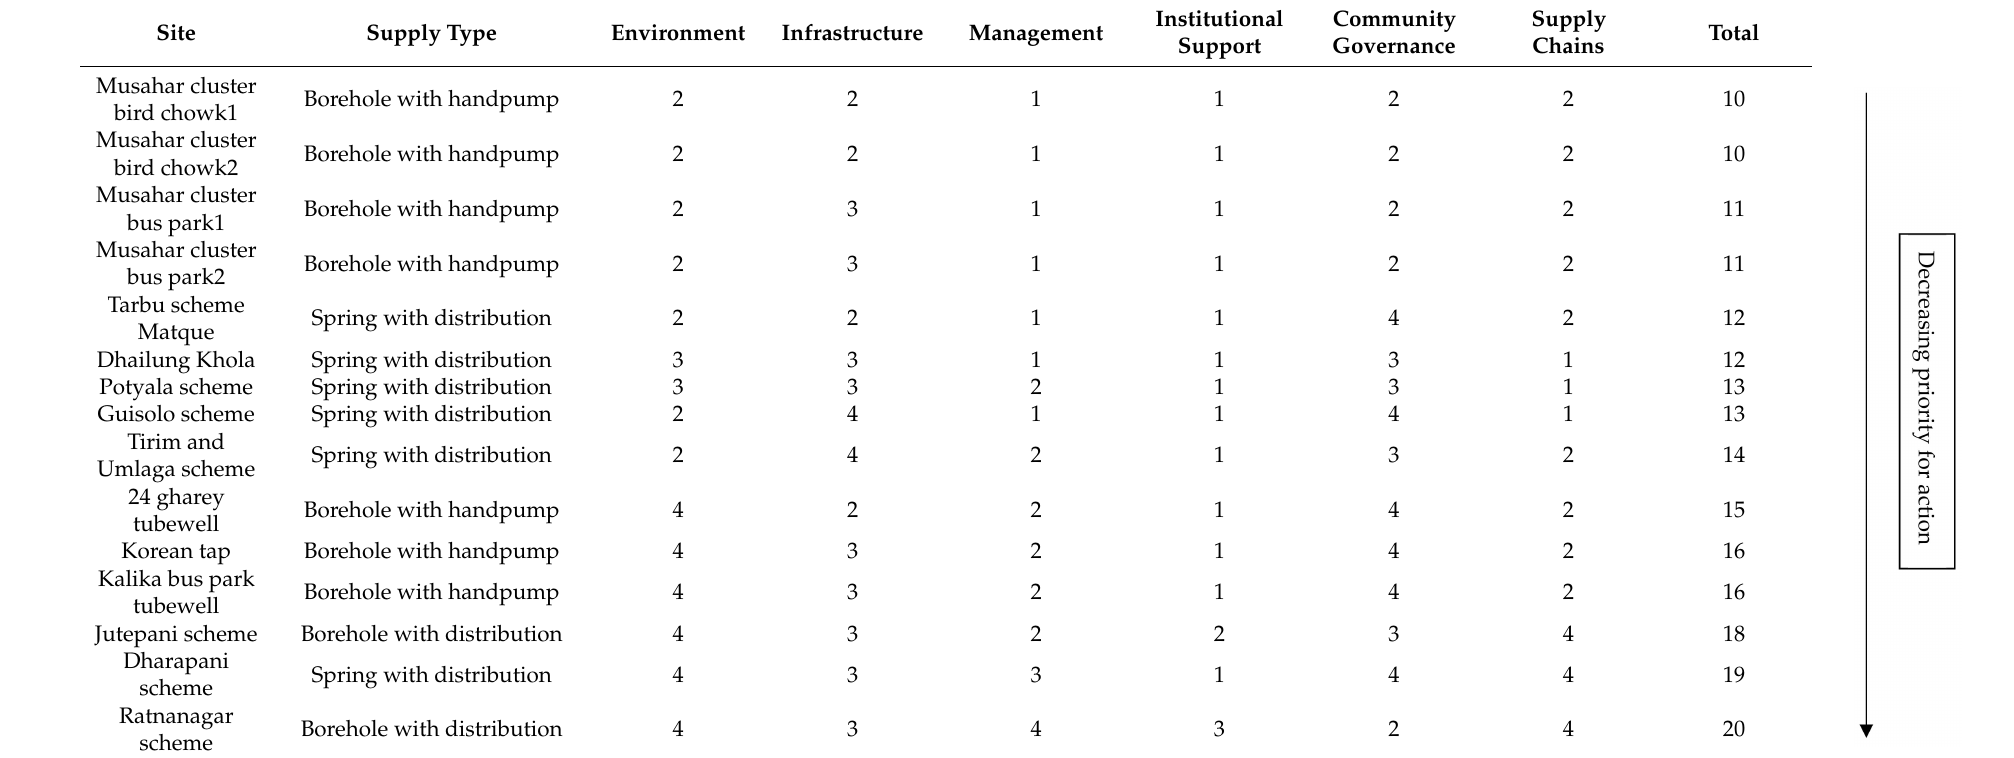
Table 5. Indicator scores for water supplies in